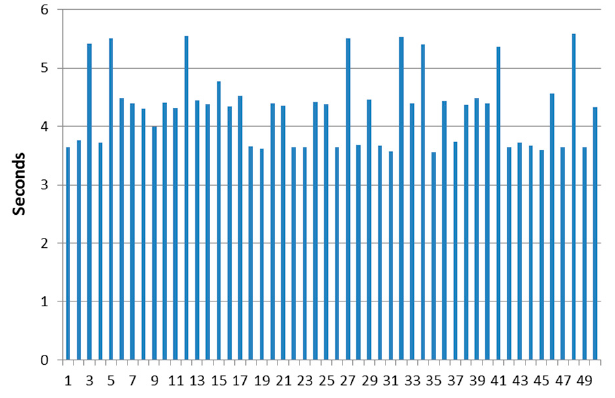
Figure 8. Time measurements for periodic environmental data subscriptions.